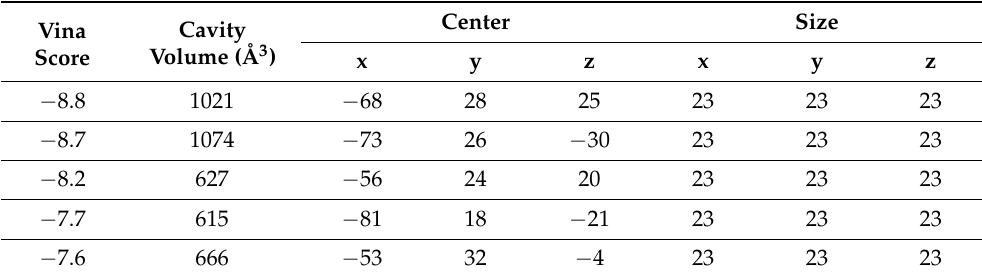
Table 3. Binding mode and the related cavity size based on the results of CB-Dock for EGCG and the receptor of 6VWW.